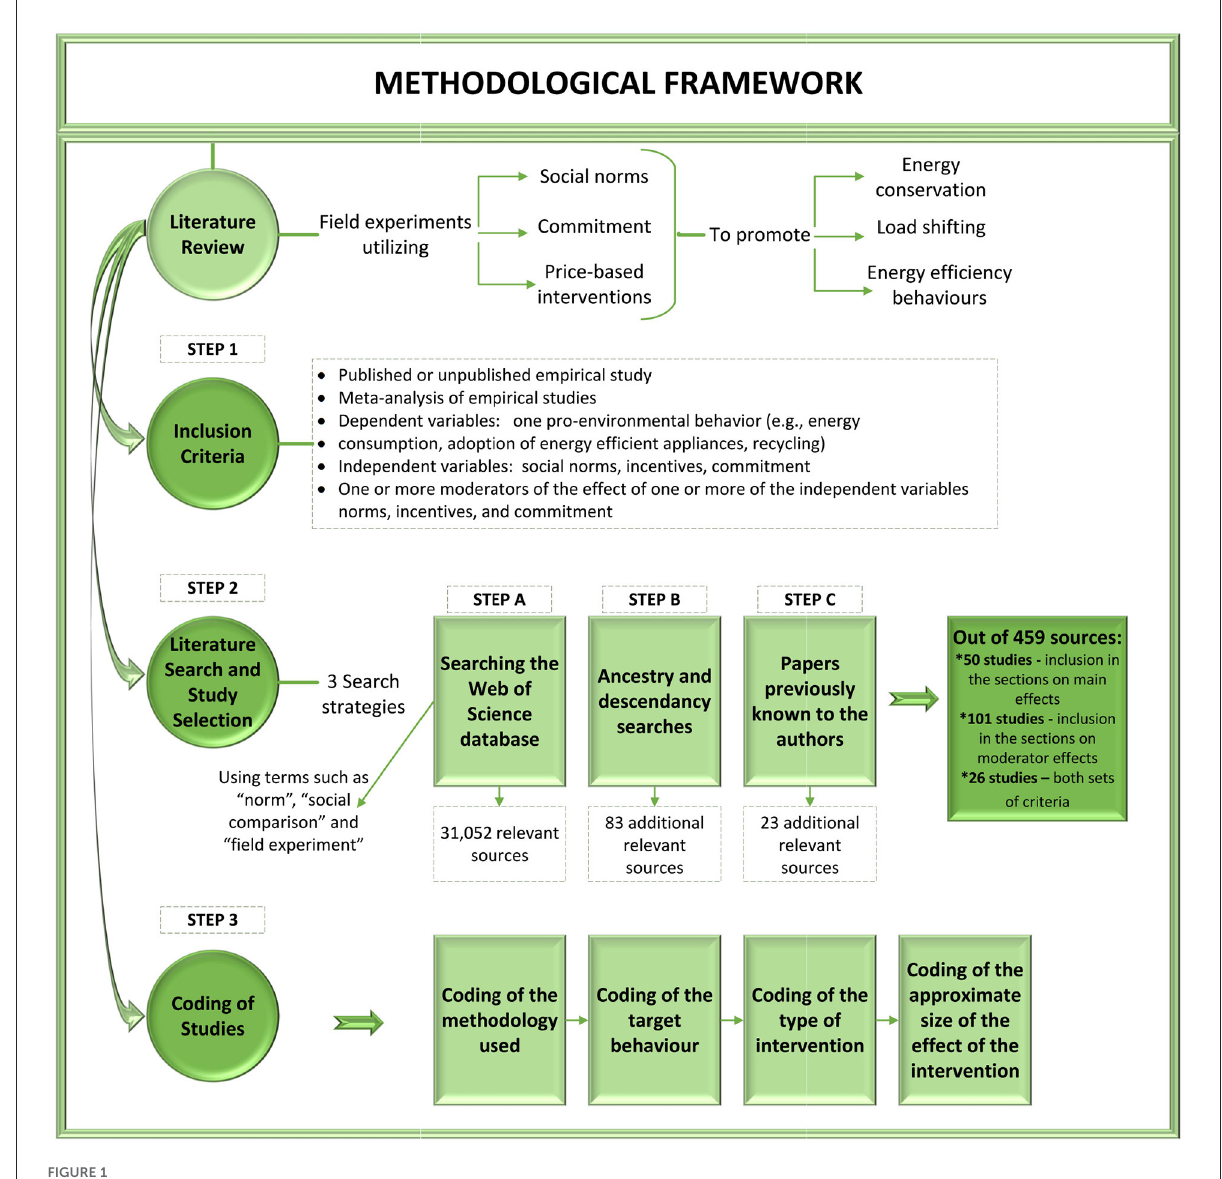
FIGURE1 Methodological